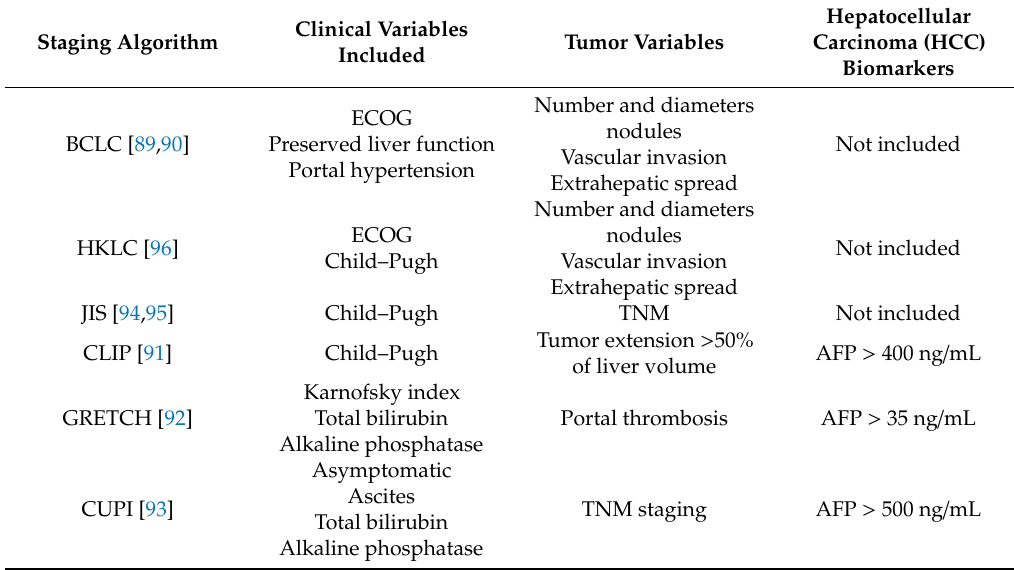
Table 2. Clinical staging algorithms for hepatocellular carcinoma (HCC) and inclusion of biomarkers. Staging